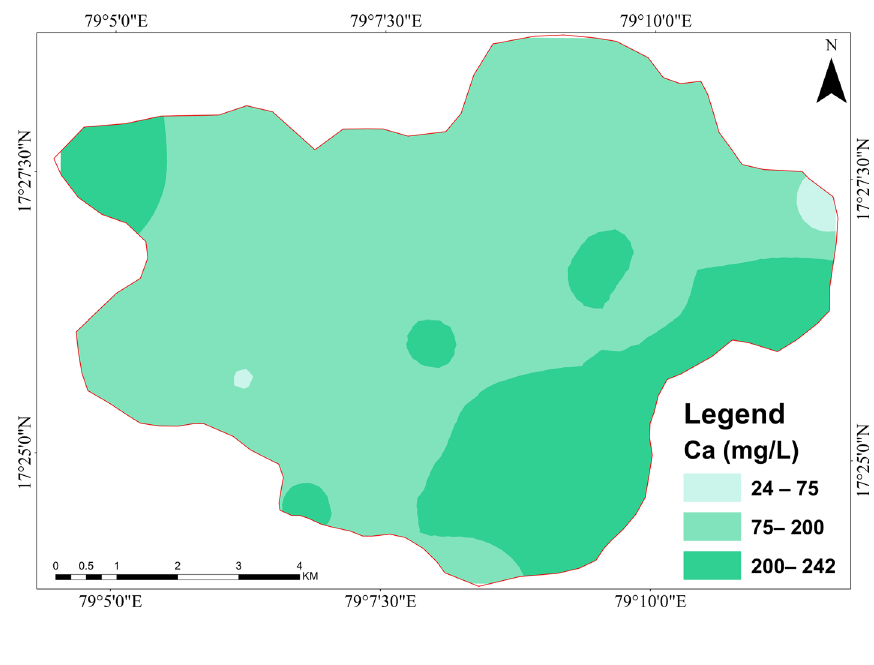
Fig. 8 Spatial distribution map of K + in Mothkur region, Telan- gana State, South